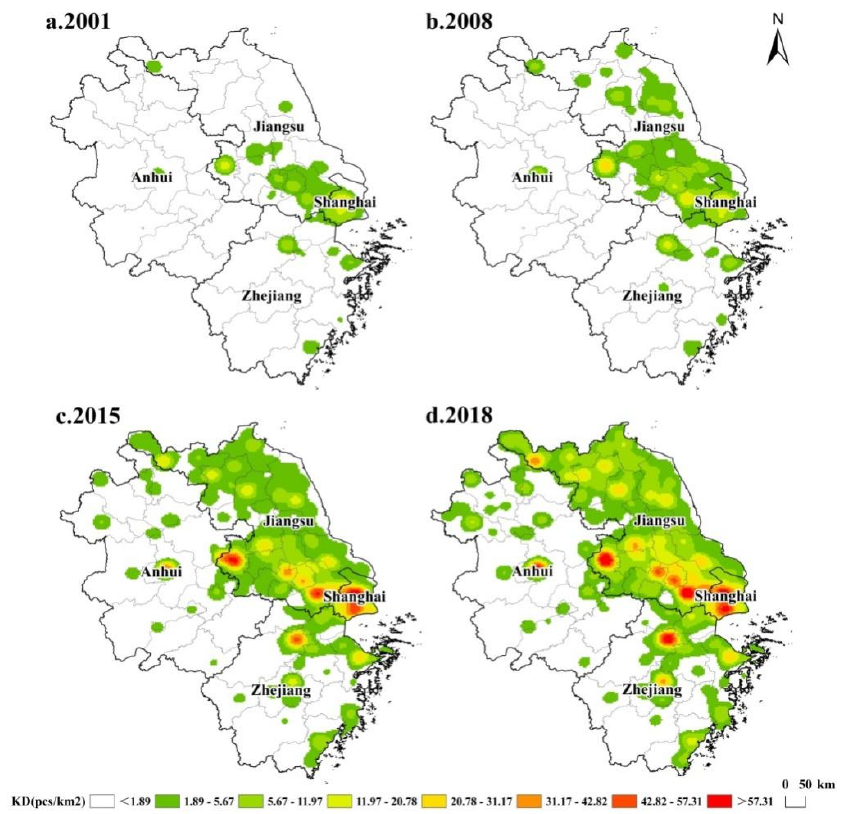
Figure 5. The spatial agglomeration status of start-ups in the Yangtze River Delta ( a ) in 2001, ( b ) in 2008, ( c ) in 2015, and ( d ) in 2018.